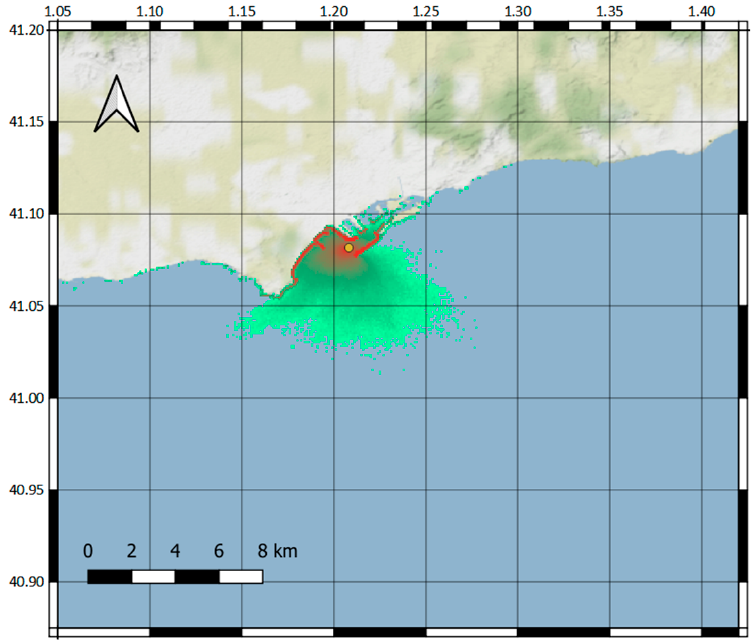
Figure 2. Impact probability map (IPM) for spills in the dock (green dot), evaluated on the coastal domain.